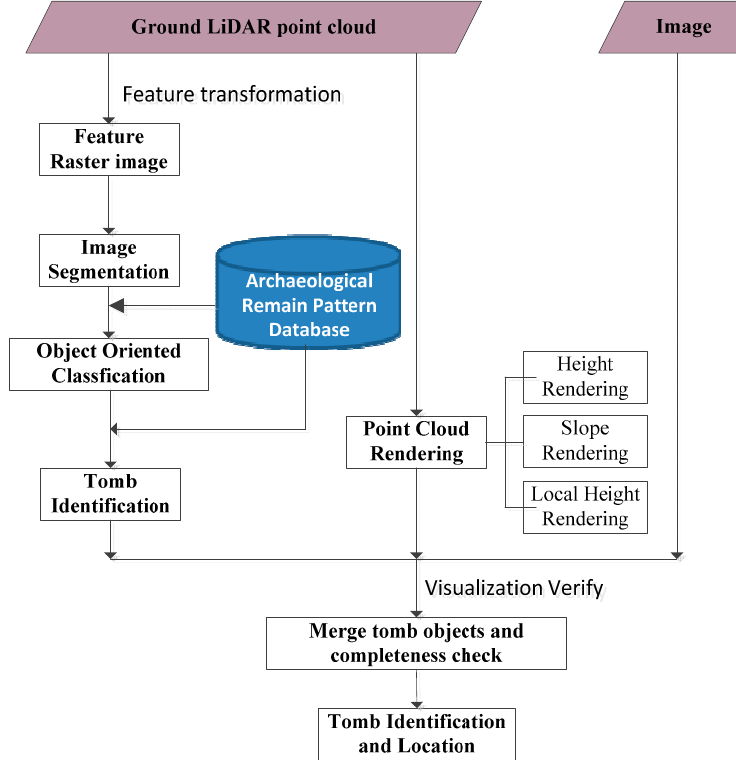
Figure 8. The identification and verification of archeological remains.